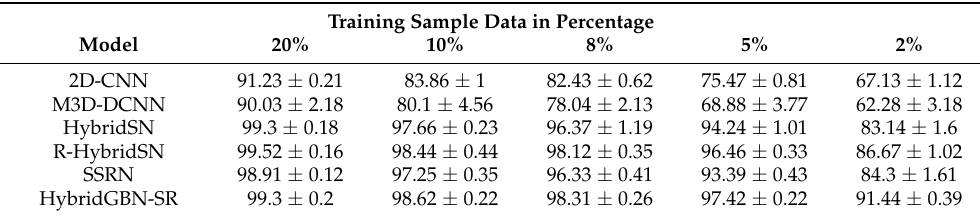
Table 7. The effect of varying the training sample data for the SSRN, Hybrid, R-HybridSN, and HybridGBN-SR models on the overall accuracy (OA) over the IP dataset.